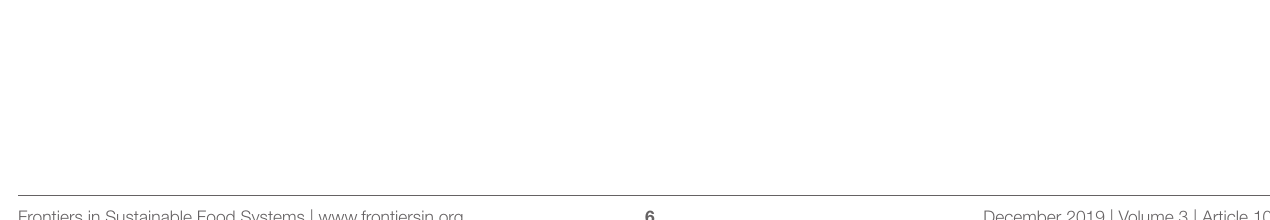
Frontiers in Sustainable Food Systems |